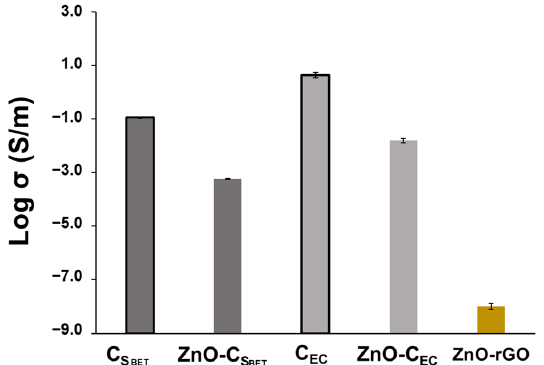
Figure 6. Electrical conductivity of biochar samples used as platform (C SBET and C EC ) and respective zinc composites (ZnO-C SBET and ZnO-C EC ). ZnO-rGO composite was used as a reference material (yellow bar).